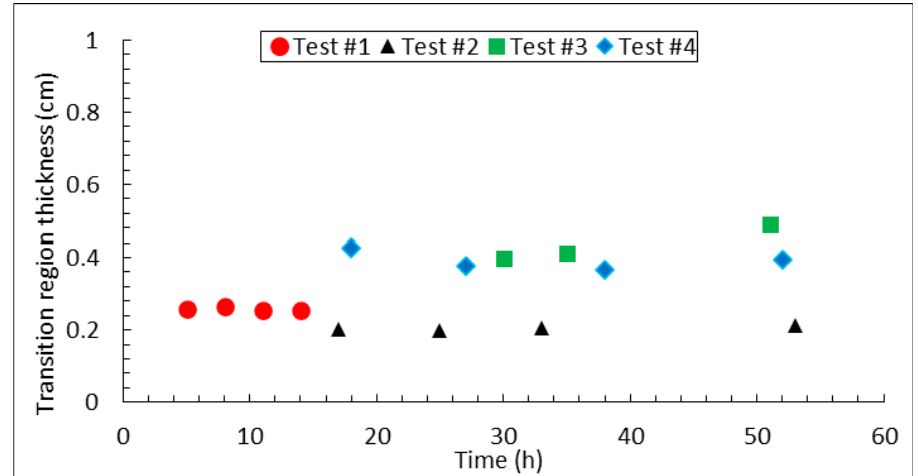
Figure 10. Actual oil production rate data for the experimental cases presented by Ma et al. [3].